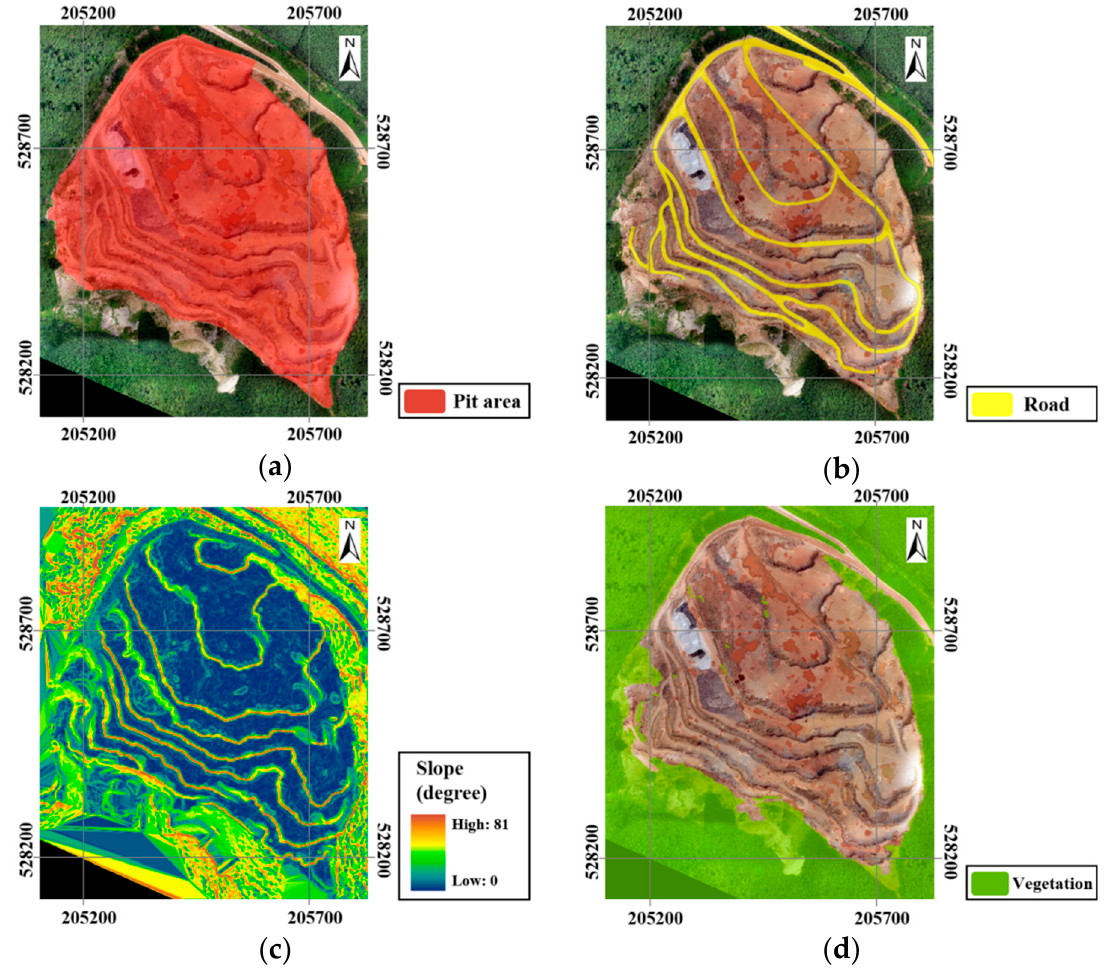
Figure 6. Input layers for selecting candidate transmitter locations in the open-pit mine: ( a ) pit area; ( b ) road; ( c ) slope gradient; and ( d ) vegetation.